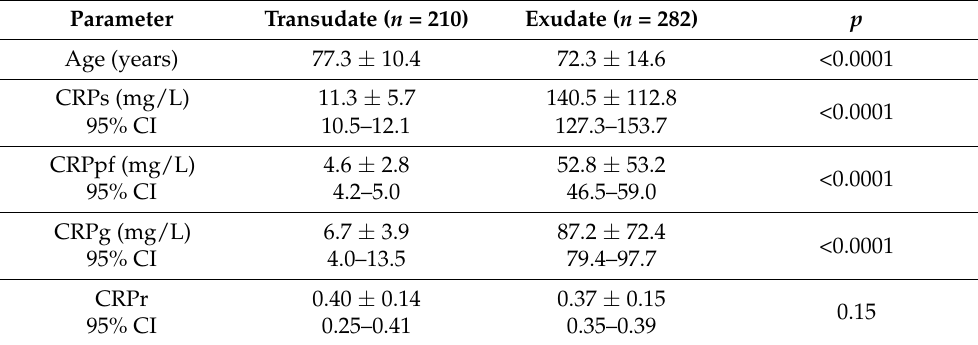
Table 1. Mean ± SD of age and mean ± SD and 95% CI of means of levels of CRPs, CRPpf, CRPg, and CRPr of transudate group and exudate group.